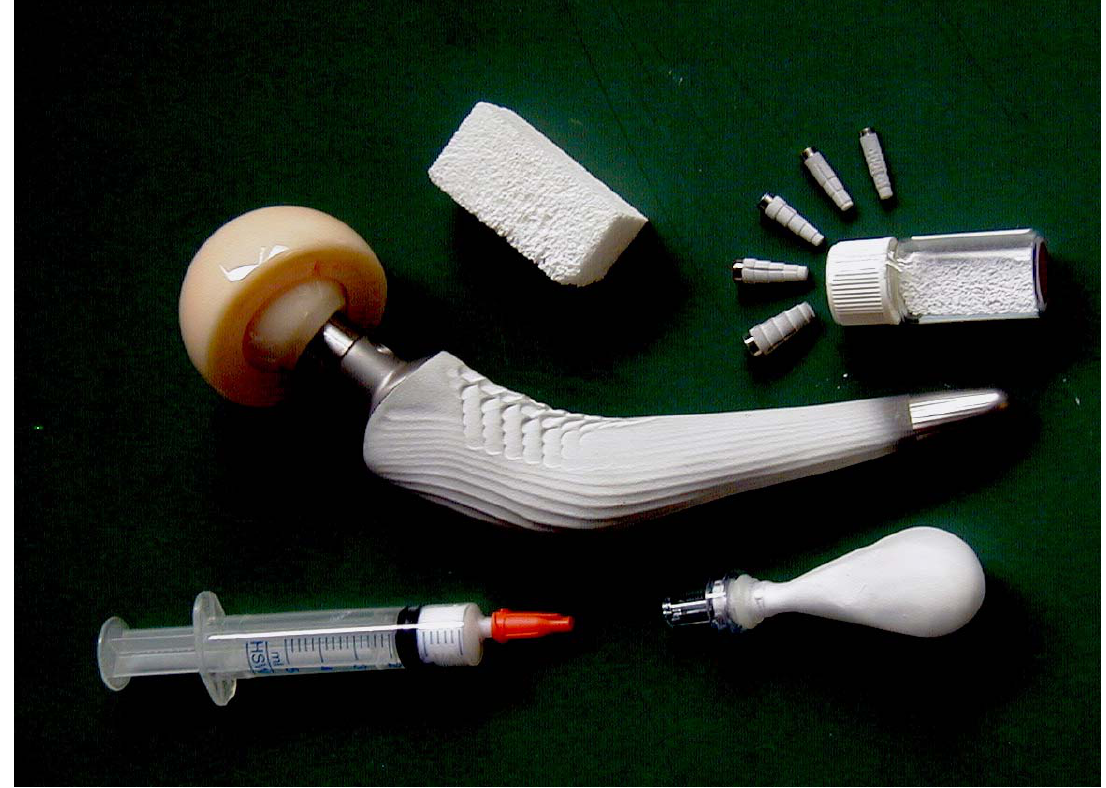
Figure 11. General appearance of various commercial calcium orthophosphate-based bone graft